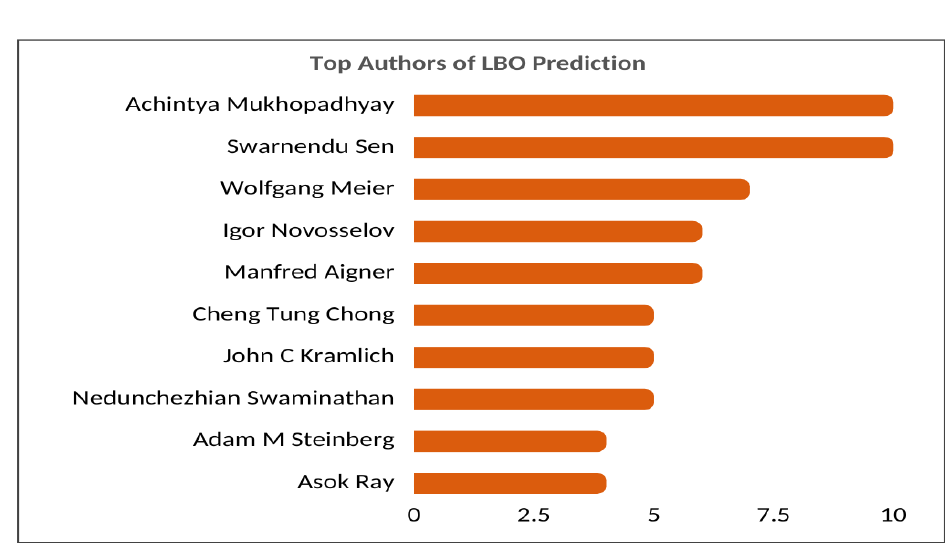
Figure 3. Top authors contributed to the LBO prediction